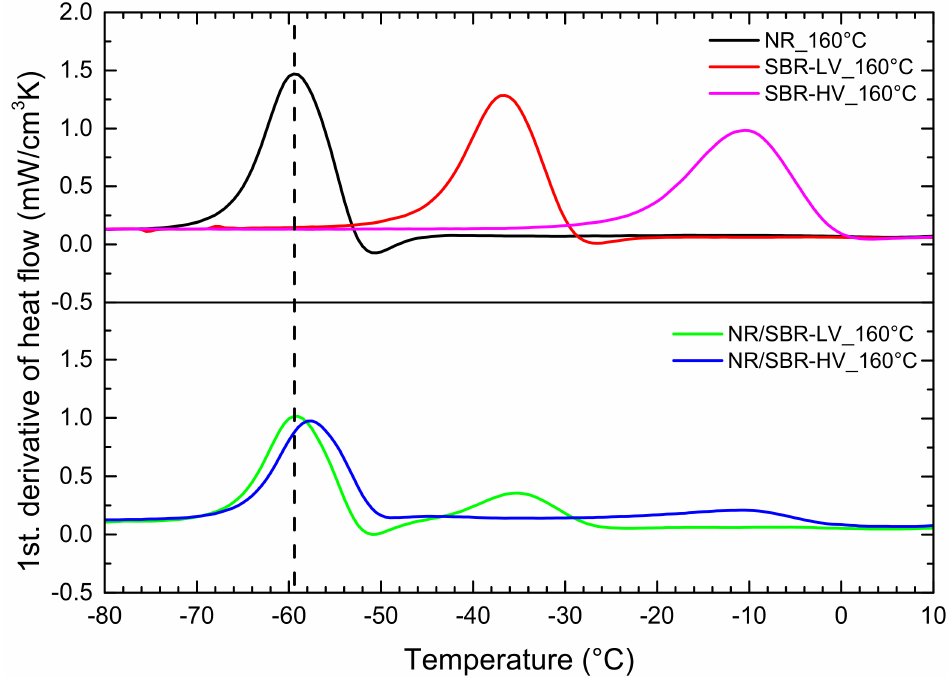
Figure 3. Differential scanning calorimetry (DSC) curves (first derivative) of the single NR, SBR–LV, SBR–HV, and their blends at a curing temperature of 160 ◦